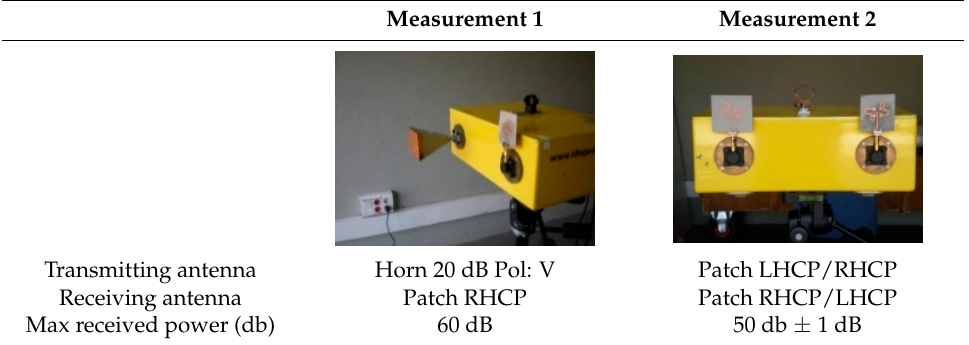
Table 2. Results of the measurements carried out to estimate the gain of the system when measuring through CP patch arrays a single target (i.e., a metal square 30 cm × 30 cm).